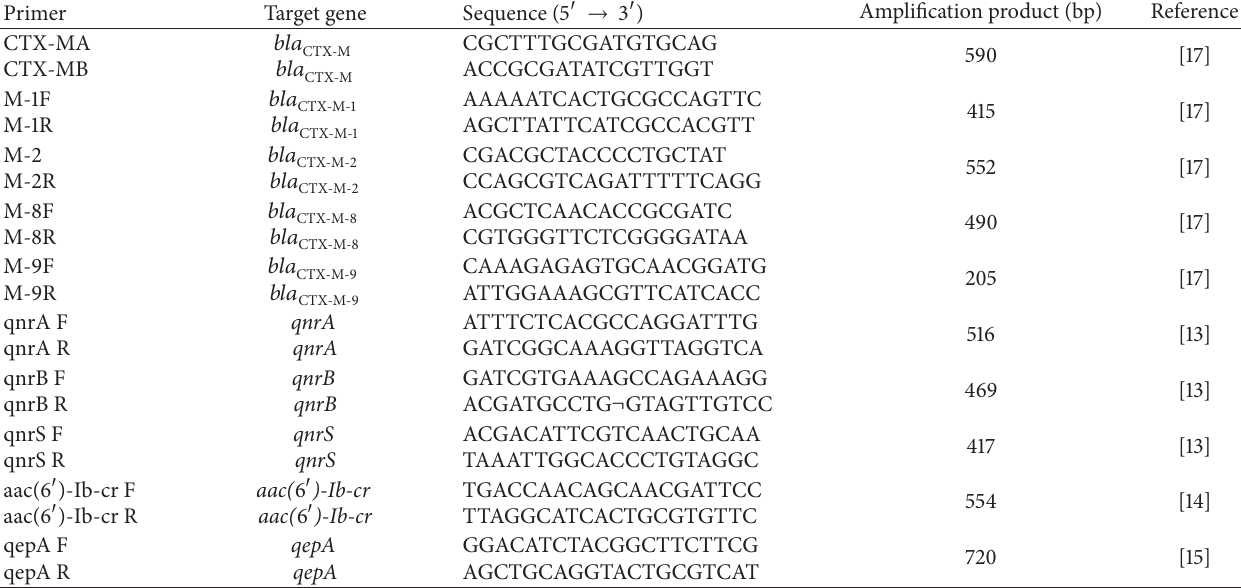
Table 1: Primers used for polymerase chain reaction and